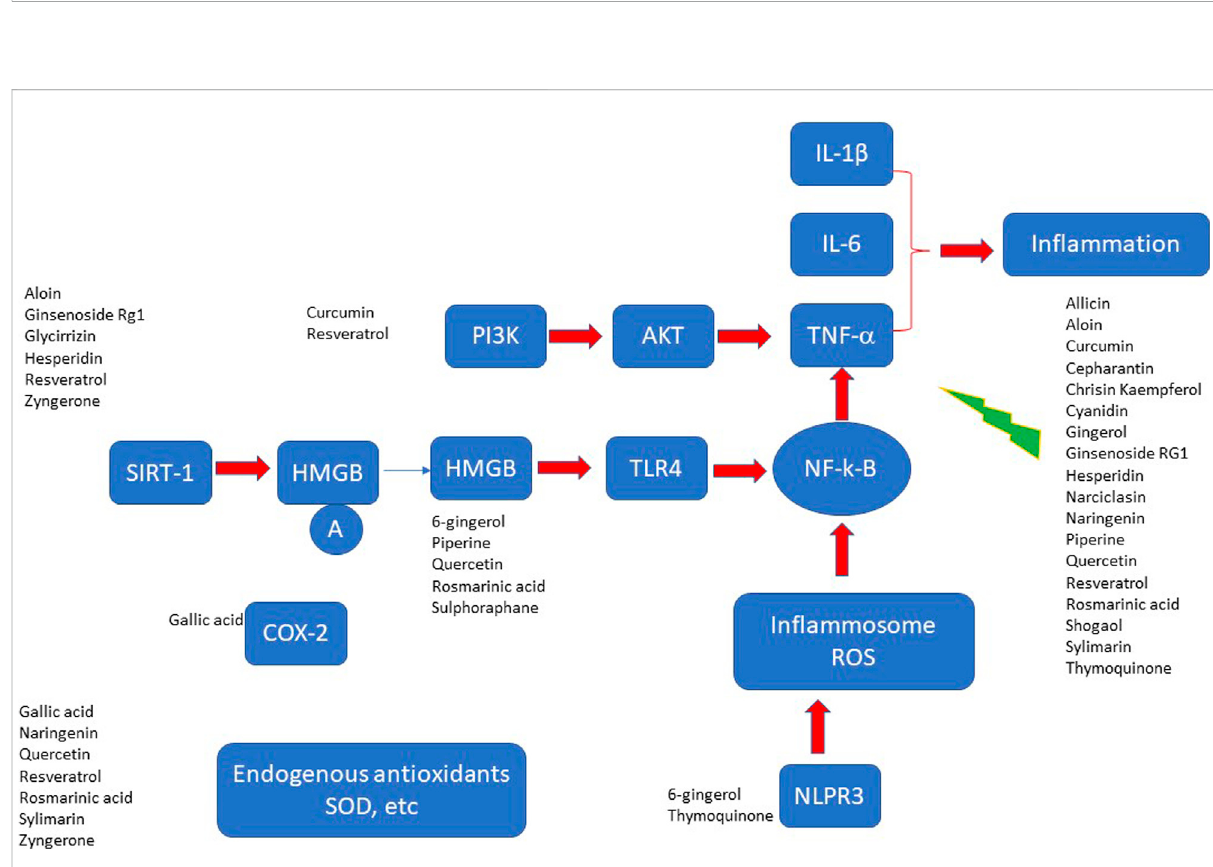
FIGURE 4 Potential targets of bioactive compounds from plants in